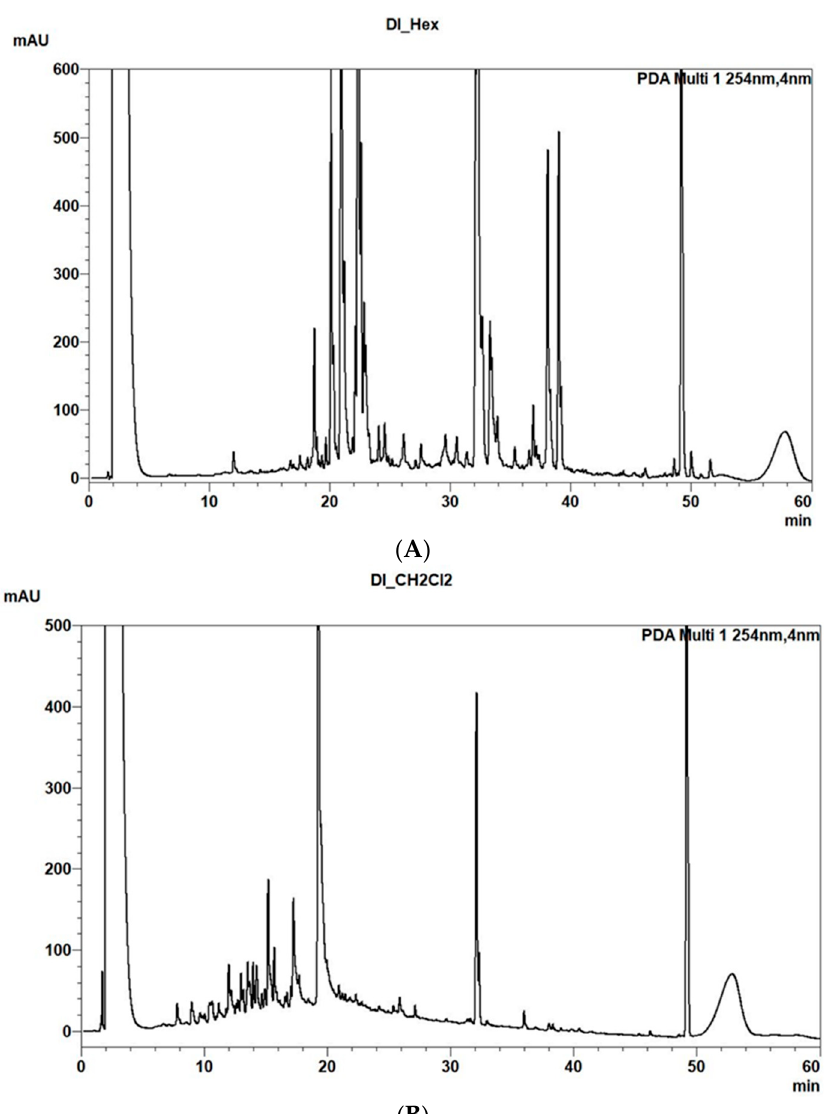
Figure 1. ( A ) PDA (Photodiode Array Extension) chromatogram of HE extract of Daucus lopadusanus recorded at 245 nm. ( B ) PDA chromatogram of MC extract of Daucus lopadusanus recorded at 245 nm.